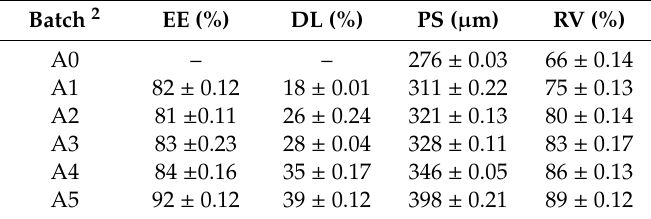
Table 2. Physicochemical parameters of insulin-loaded MPs ( n = 5). 1